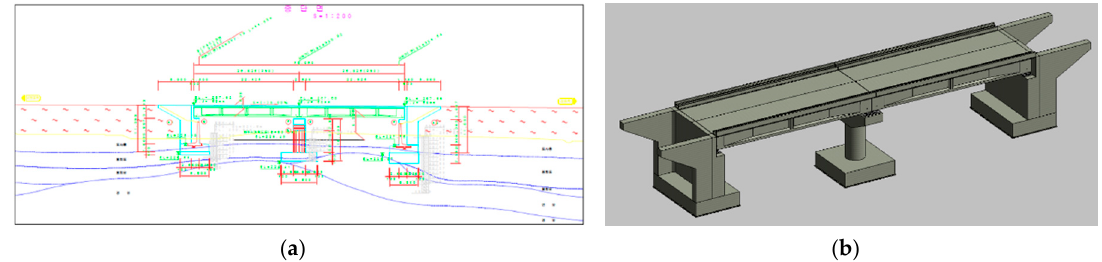
Figure 2. ( a ) 2D drawing and ( b ) BIM Model (using the library).